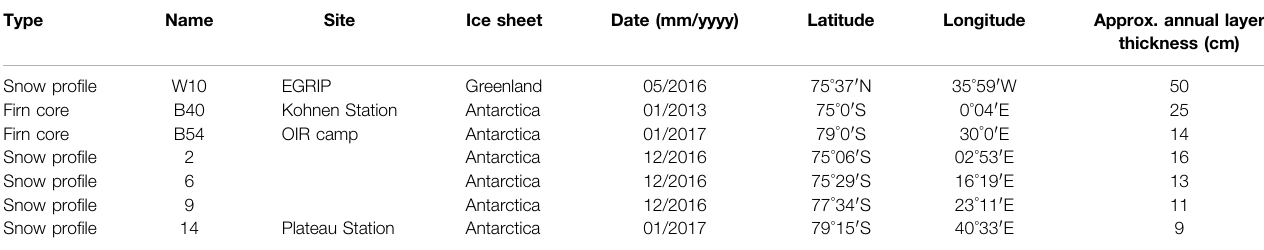
TABLE 1 | Overview of investigated fi rn cores and snow pro fi les. See Figure 1 for the locations on both ice